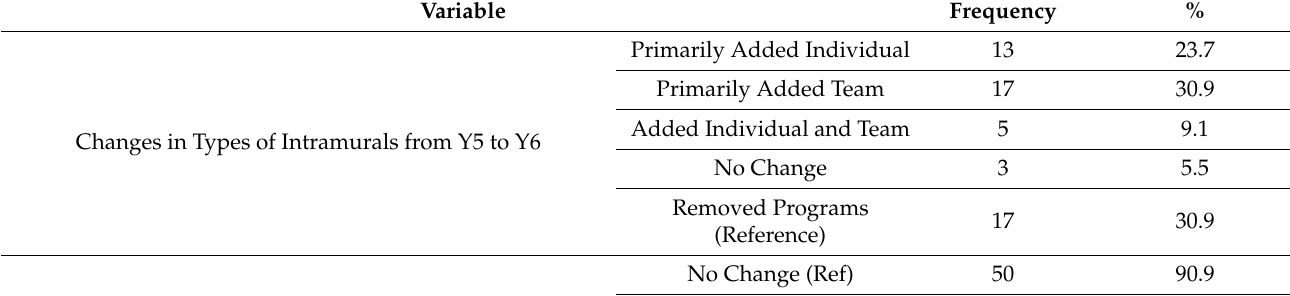
Table 1. Descriptive Statistics for School-Level Characteristics for the sample ( n = 55) from Year 5 and 6 (2016–2017) of the COMPASS